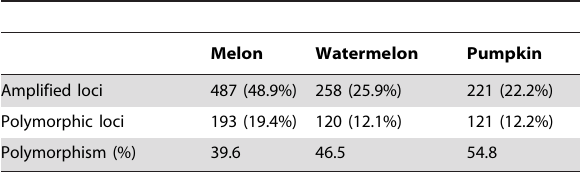
Table 2. Cross-species transferability of 995 cucumber genomic SSR markers in melon, watermelon and